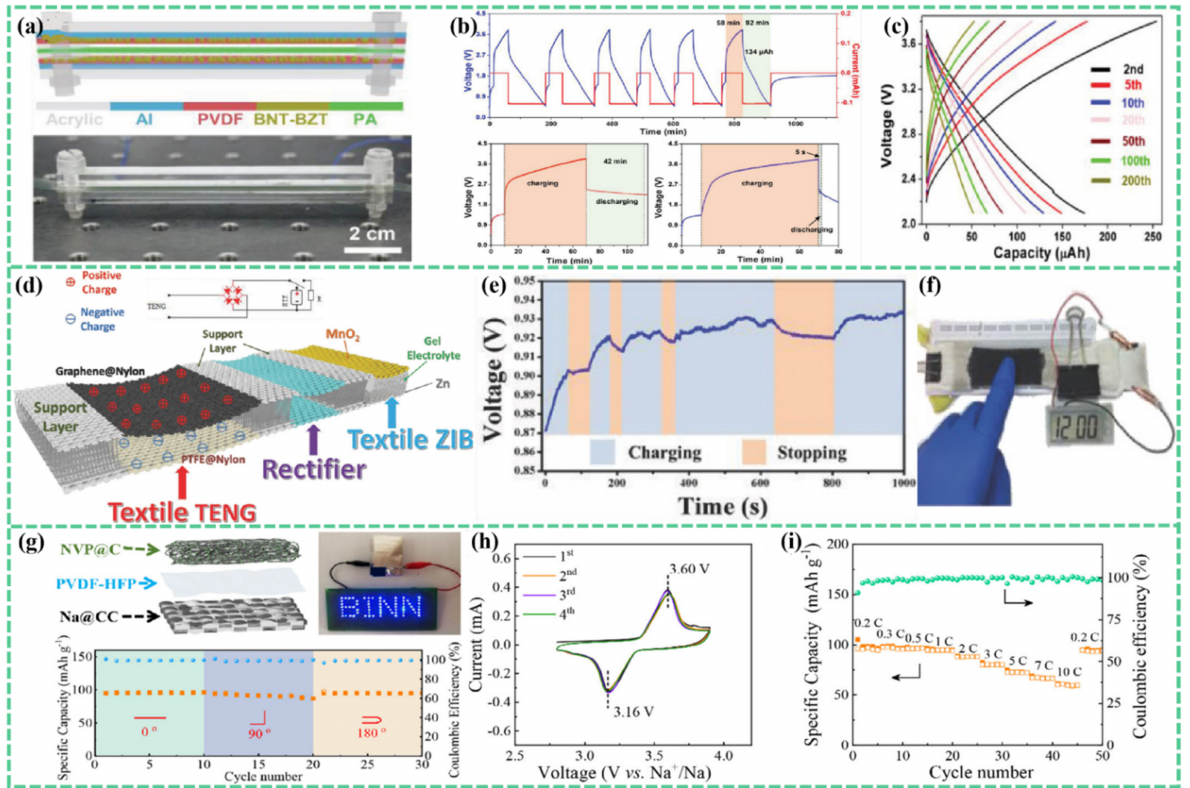
Figure 10. ( a – c ) A TENG-UPS that uses TENG to collect wind energy and effectively store the con- verted electric energy in a matching ASS-LIB. ( a ) A schematic diagram of the TENG. ( b ) Applications of the TENG-UPS in self-powered electronics. ( c ) Electrochemical performance of ASSLIB. Repro- duced with permission [101]. Copyright 2022, Wiley-VCH. ( d – f ) A TENG-UPS device was integrating a TENG and a ZIB on a flexible 3D spacer fabric. ( d ) Manufacturing protocol and schematic diagram of energy harvesting and storage device. ( e ) The voltage evolution characteristics of the flexible ZIB under the normal charging and stopping modes. ( f ) Electronic watch driven by flexible ZIB charged by TENG through manual pressing. Reproduced with permission [102]. Copyright 2018, Wiley- VCH. ( g – i ) A flexible quasi-solid state sodium battery for storing pulsed electricity generated by a TENG. ( g ) Schematic illustration of the NVP-C|PVDF-HFP|Na-CC sodium battery. ( h ) CV curves at 1 mV s − 1 . ( i ) Rate capability at different current densities. Reproduced with permission